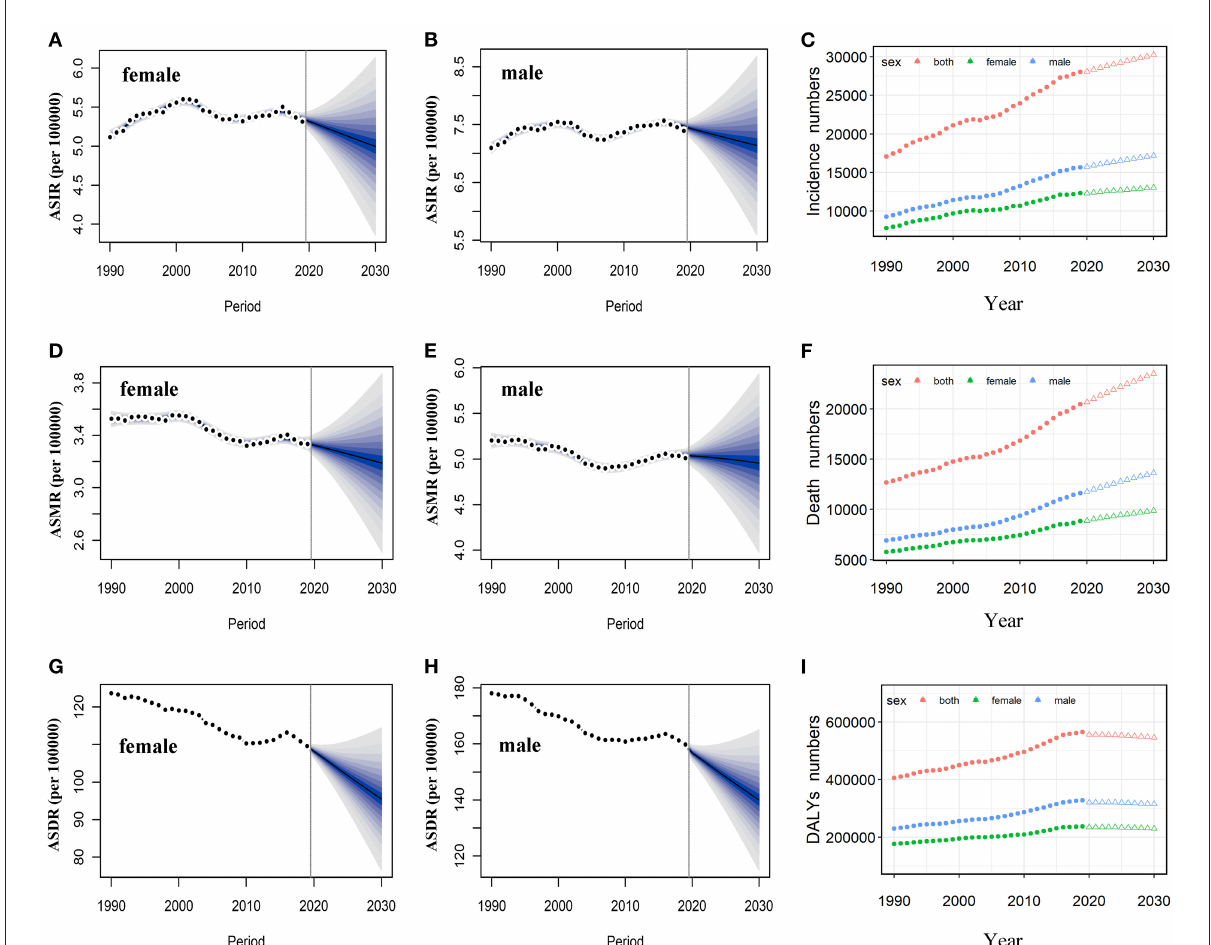
FIGURE7 Temporal trends and projected ASIR, ASMR, and ASDR by sex, from 1990 to 2030 in the US. Projected temporal trends of ASIR for women (A) and men (B) in the US from 1990 to 2030. Projected temporal trends of ASMR for women (D) and men (E) in the US from 1990 to 2030. Projected temporal trends of ASDR for women (G) and men (H) in the US from 1990 to 2030. Projected numbers of incidences (C) , deaths (F) , and DALYs (I) from 1990 to 2030 in the US. Observed (dashed lines) and predicted rates (solid lines). The fan shows the predictive distribution between the 5 and 95% quantiles. Observed (solid circle) and predicted numbers (triangle). DALYs, disability-adjusted life years; CNS, central nervous system; ASIR, age-standardized incidence rate; ASMR, age-standardized mortality rate; ASDR, age-standardized disability-adjusted life years